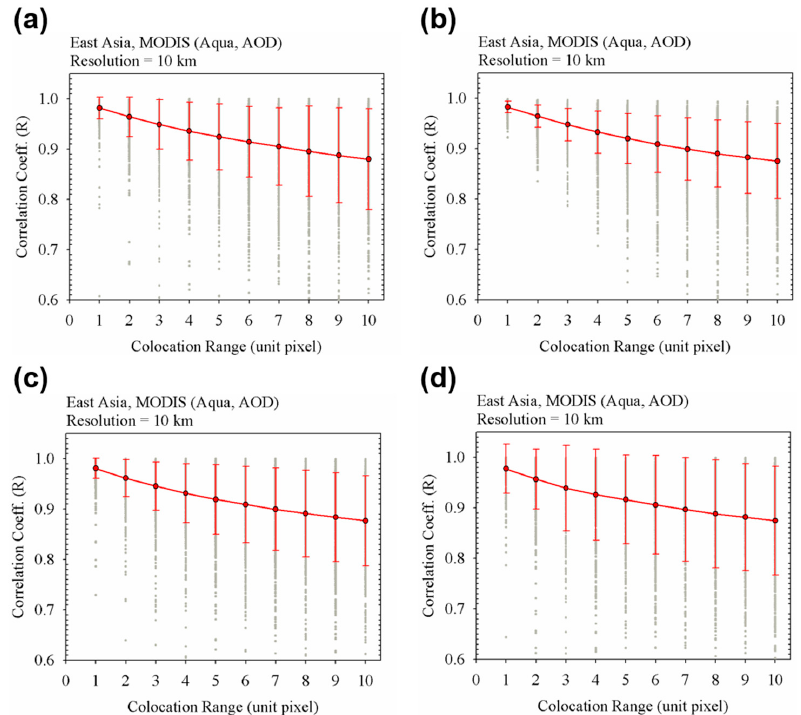
Figure 5. Distribution of correlation coefficient (R d ) for AOD in East Asia with respect to the colocation range in ( a ) spring, ( b ) summer, ( c ) autumn, and ( d ) winter. range in ( a ) spring, ( b ) summer, ( c ) autumn, and ( d )